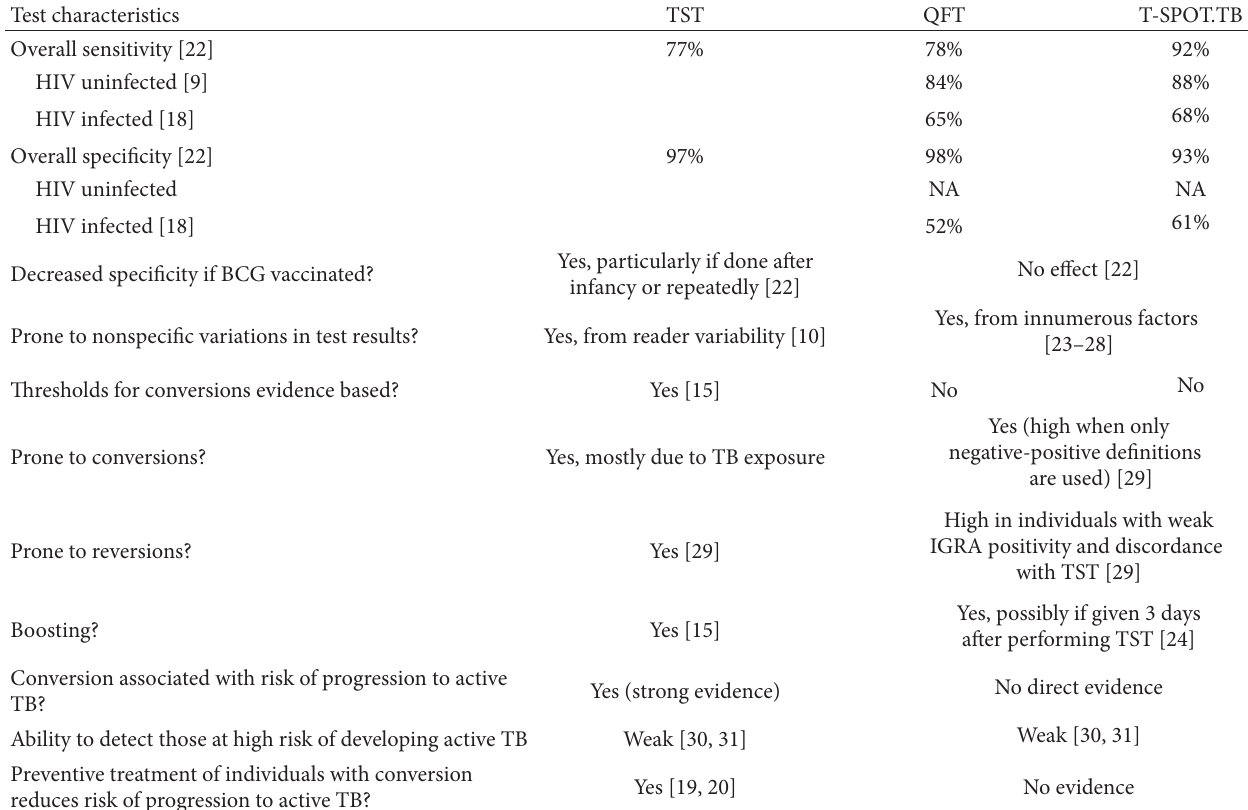
T 1: Comparison of TST and IGRA regarding several tests’